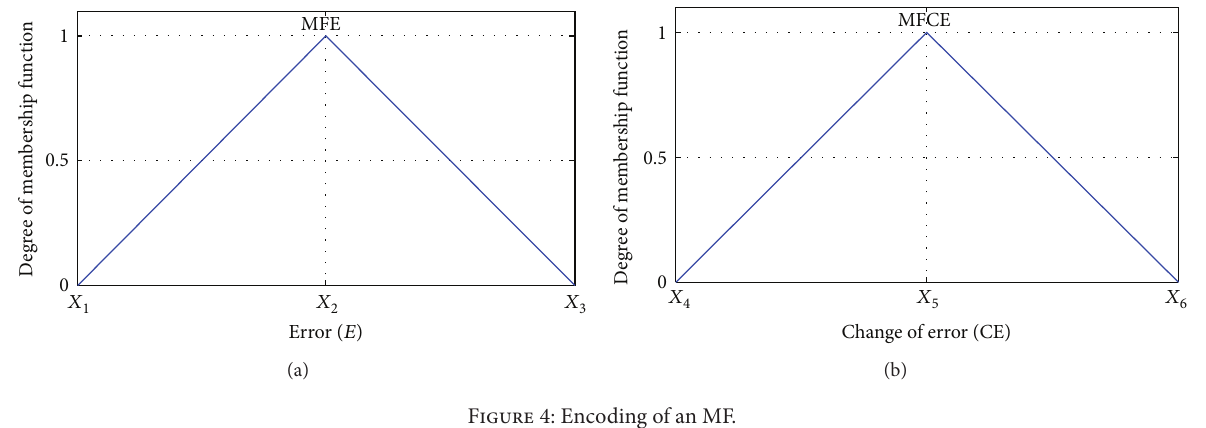
Figure 4: Encoding of an